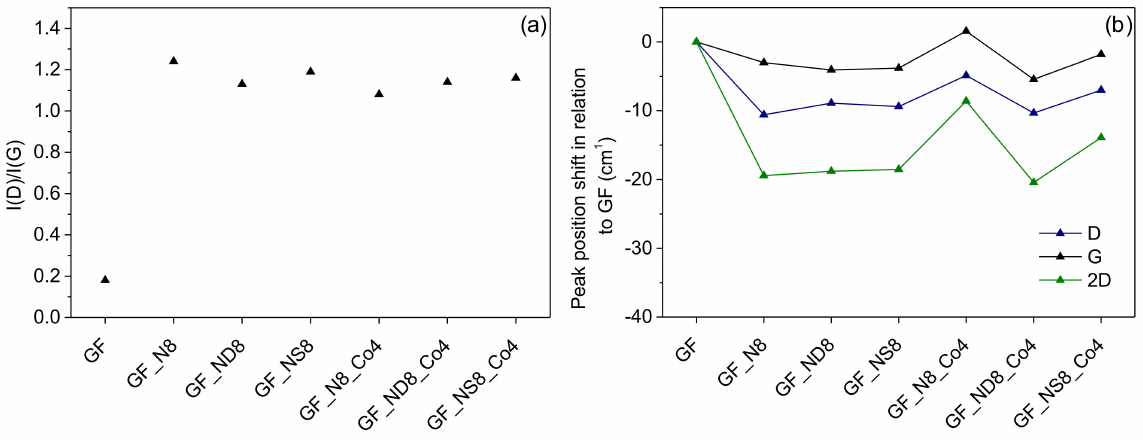
Figure 3. ( a ) Calculated ID/IG ratio for the pristine and doped/modified GF materials; ( b ) Raman red shift of the D, G, and 2D bands of the doped/modified materials in comparison to pristine